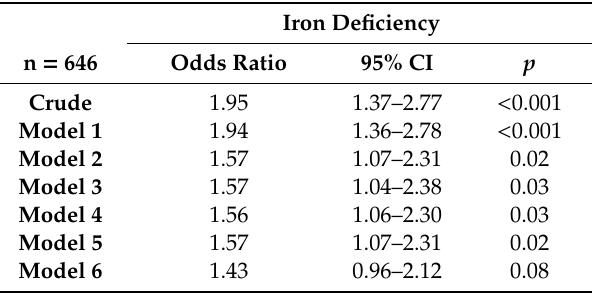
Table 3. Logistic regression analyses investigating the association of PPI use with iron deficiency in 646 renal transplant